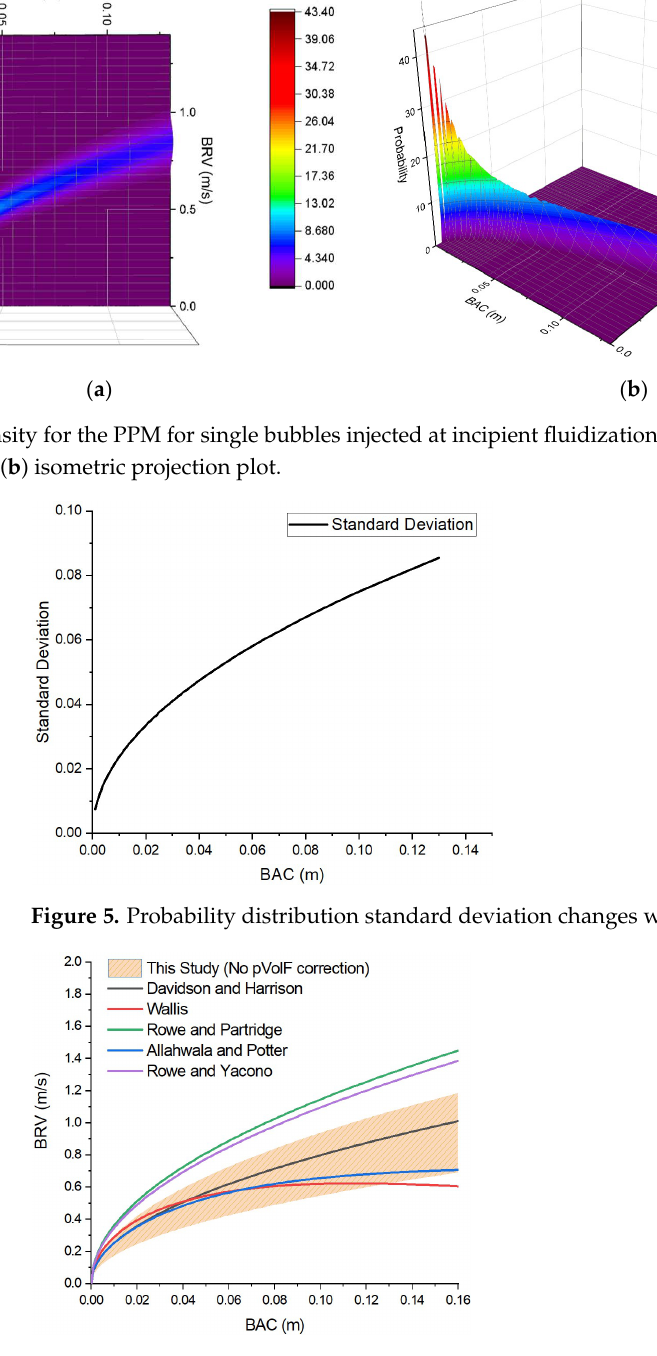
Figure 4. Probability density for the PPM for single bubbles injected at incipient fluidization conditions: ( a ) top view of the probability density plot; ( b ) isometric projection plot.